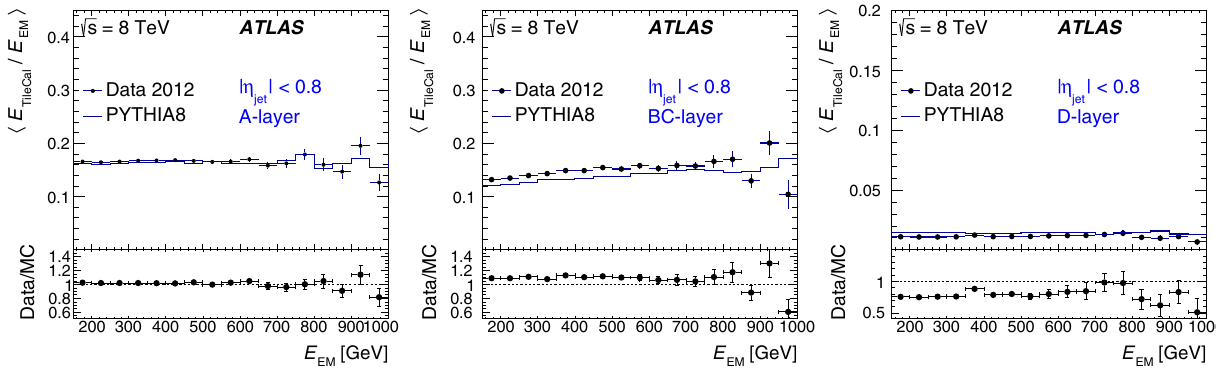
Fig. 25 Electromagnetic scale jet energy fraction in the TileCal for jets with p T > 140GeV in the long barrel ( | η jet | < 0 . 8) for layer A (left), layer BC (middle), and layer D (right). Error bars represent statistical uncertainties